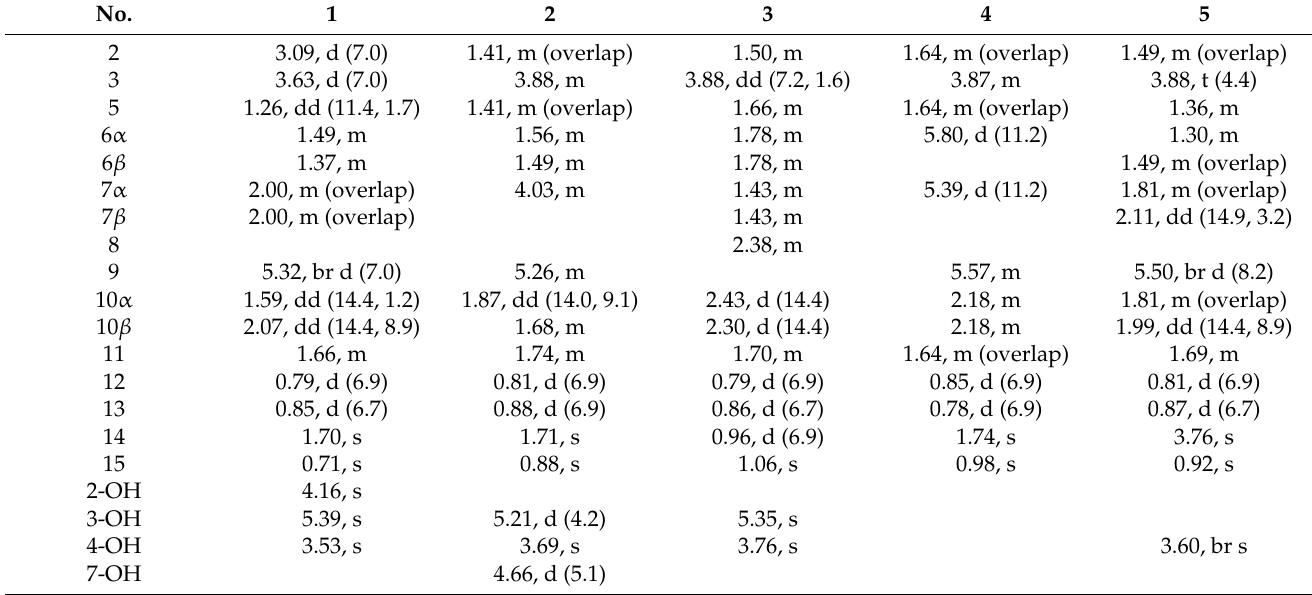
thine group in 1 . COSY and HMBC data (Figure 2) supported the above deduction. The planar structure of 1 was thus determined. Table 1. 1 H NMR Data for Compounds 1 – 5 in DMSO- d 6 (500 MHz).